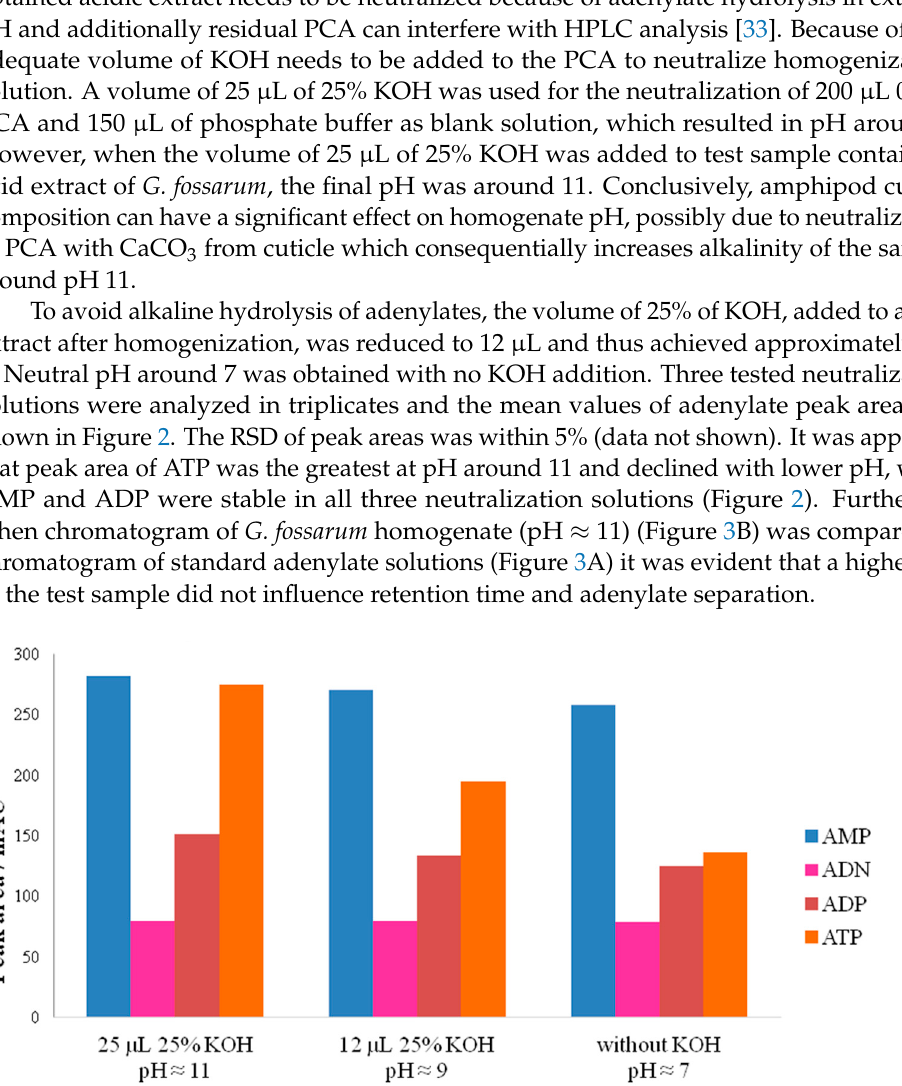
Figure 3. HPLC chromatograms of adenylate standards ( A ) and adenylates extracted from G. fossarum samples (B–D). ( A ) standards AMP, ADN, ADP, and ATP in the concentration of 25 μ M; ( B ) G. fossarum homogenate with pH around 11; ( C ) fraction 1 of G. fossarum sample enriched on AssayMap Bravo platform; ( D ) fraction 2 of G. fossarum sample enriched on AssayMap where no AMP and ADN were eluted. For chromatographic separation conditions see Section 2.4. 3.3. Improved Sensitivity with PP μ SPE Biological samples often contain impurities derived from biological molecules (e.g., lipids and proteins) or inorganic material (e.g., exoskeleton) that can interfere while meas ‐ uring molecules of interest, especially if the analytes are present at low levels. Considering the different polarity of AMP, ADP, and ATP and basic nature of named molecules, sep ‐ aration and purification are quite challenging. A previously published method for SPE of